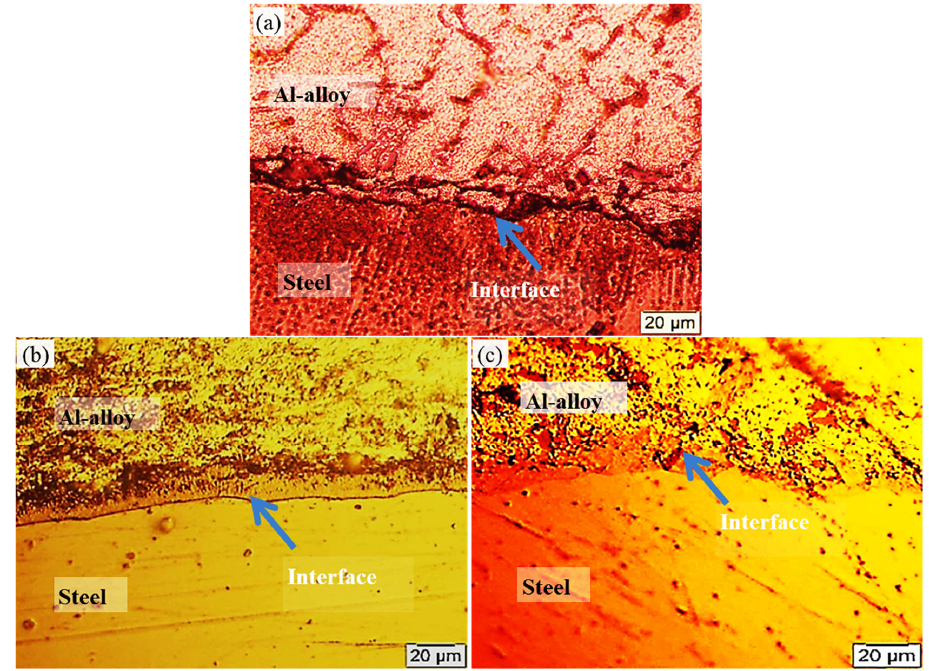
Figure 4. Optical interfacial microstructures of bimetallic materials with tin-to-flux ratios of ( a ) 1:5, ( b ) 1:10 and ( c ) 1:15.